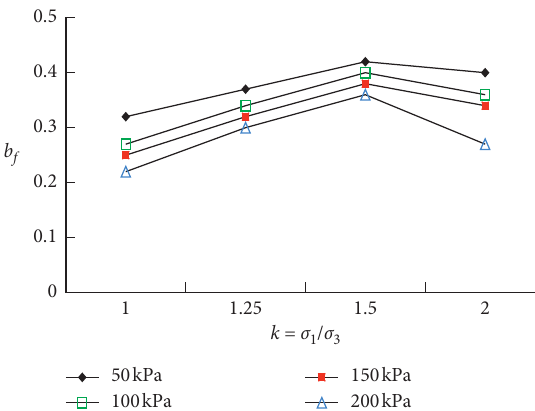
Figure 13: Change law between b